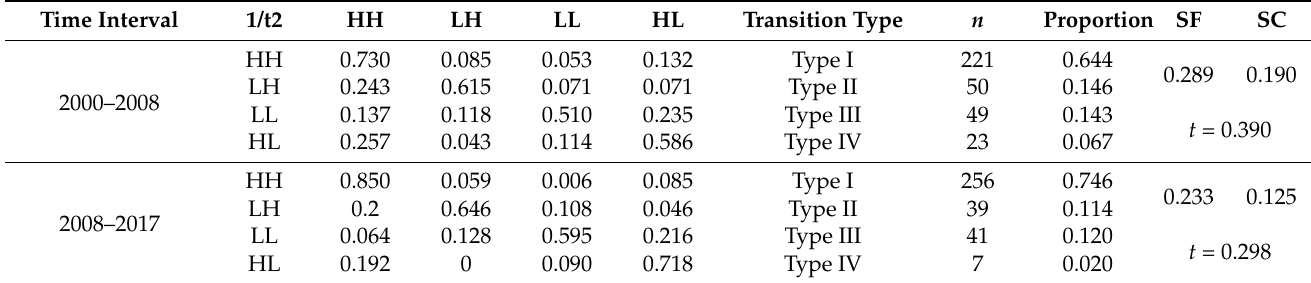
Table 2. Spatiotemporal transition matrices of USI in China.